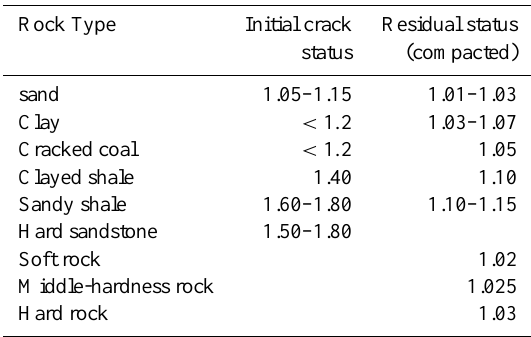
Table 1. Hulking coefficient values of cracked rock ( k